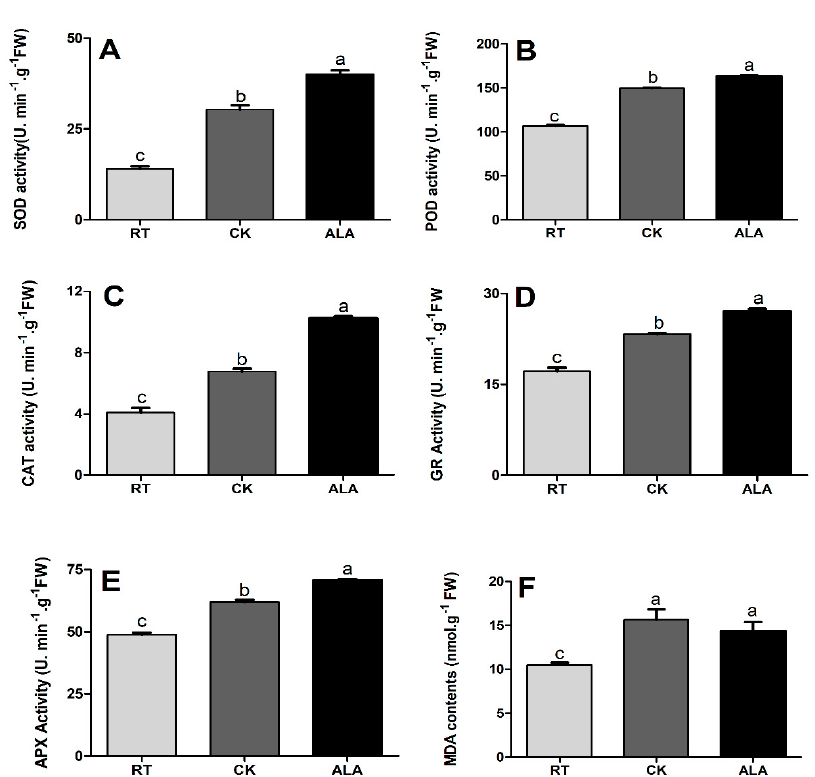
Figure 3. The effect of ALA on antioxidant enzymatic activities ( A : SOD = superoxide dismutase, B : POD = peroxidase, C : CAT = catalase, D : APX = ascorbate peroxidase, E : GR = glutathione reductase, and F : MDA = malondialdehyde) under low-temperature stress in cucumber seedlings. RT = regular temperature; CK = control; ALA = 30 mg/L ALA. Different letters indicate a significant difference at p < 0.05.